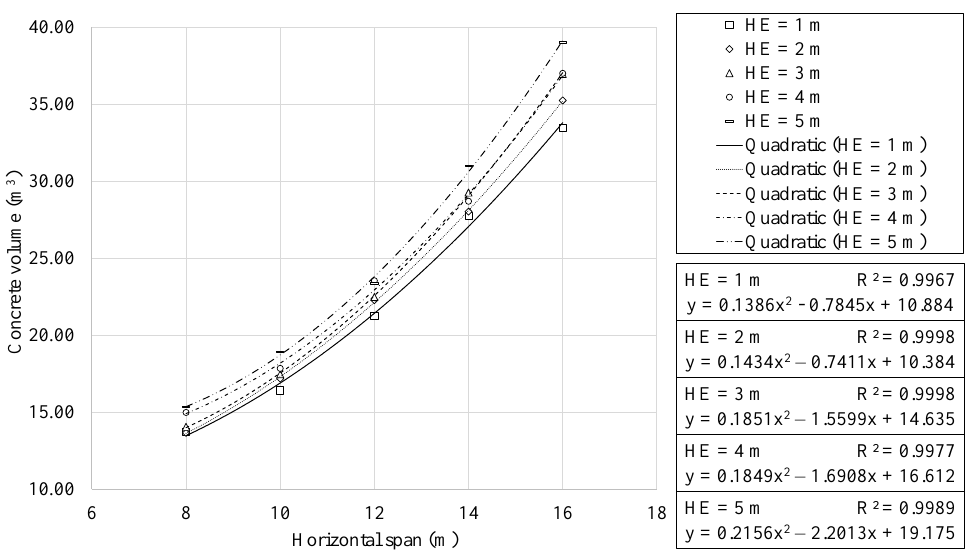
Figure 9. Concrete volume as function of horizontal span, for each earth cover depth.